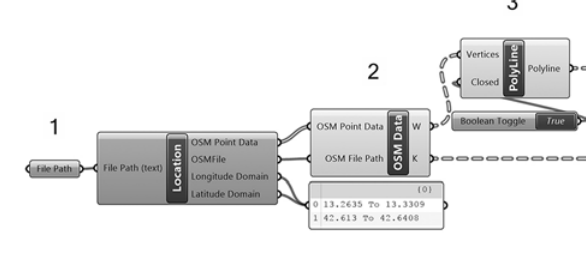
Figure 5. Instructions of the macro using .osm files